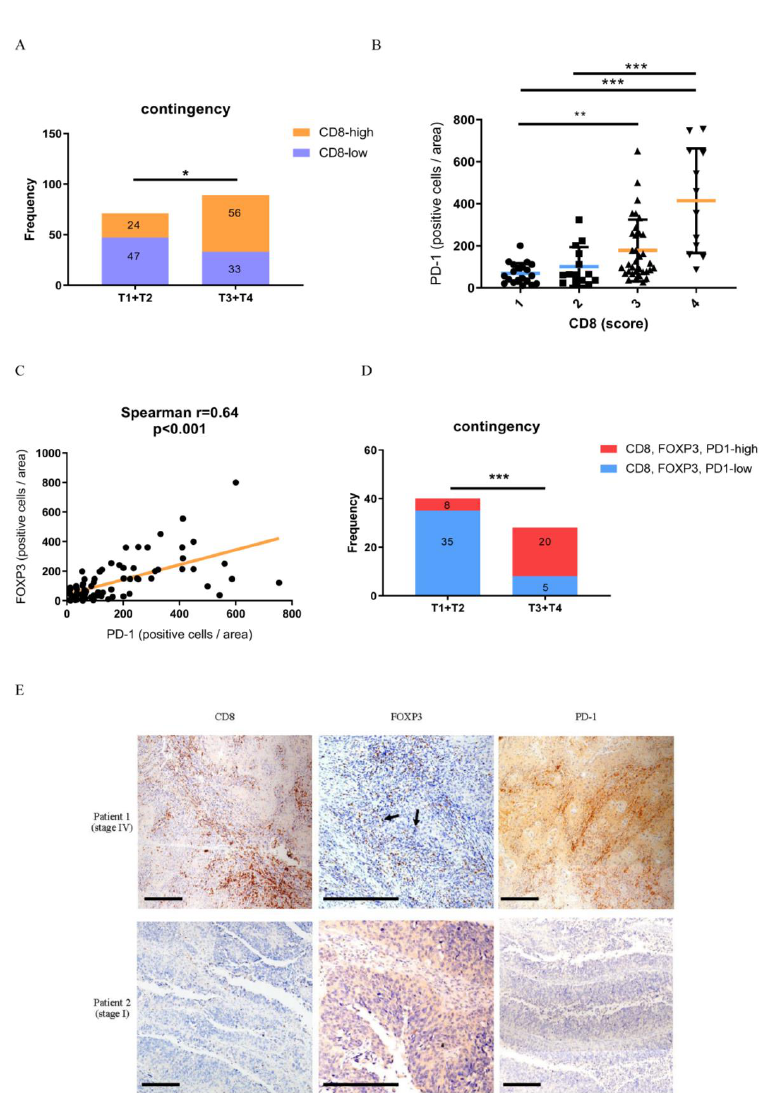
Figure 3. A subpopulation of patients with late-stage UC co-express CD8, PD-1, and FOXP3 in the tumor microenvironment. ( A ) IHC score of CD8 from 80 UC tumor specimens was divided into two groups by early (I + II) and late (III + IV) stage. The median value was used as a cut-off for CD8 expression. Analysis was performed using the Chi-square test. *, p < 0.05. ( B ) IHC score of CD8 and PD-1 from 37 late-stage UC tumor specimens. The PD-1 expression level was analyzed by one-way ANOVA. *, p < 0.05; **, p < 0.01. ( C ) The Spearman correlation test was used to analyze IHC scores of PD-1 and FOXP3. ( D ) IHC scores of CD8, FOXP3, and PD-1 from 40 UC tumor specimens were divided into two groups by early (I + II) and late (III + IV) stage. The median value was used as a cut-off for expression. Analysis was performed using the Chi-square test. ***, p < 0.001. ( E ) Representative images of CD8, FOXP3, and PD-1 IHC in patients with late-stage and early-stage UC. The positive signal of TILs is presented as brown “dots” indicated by arrow in the tumor section. Scale bar: 200 µ M. UC, urothelial carcinoma; PD-1, programmed cell death protein 1; IHC, immunohistochemistry; TILs, tumor-infiltrating